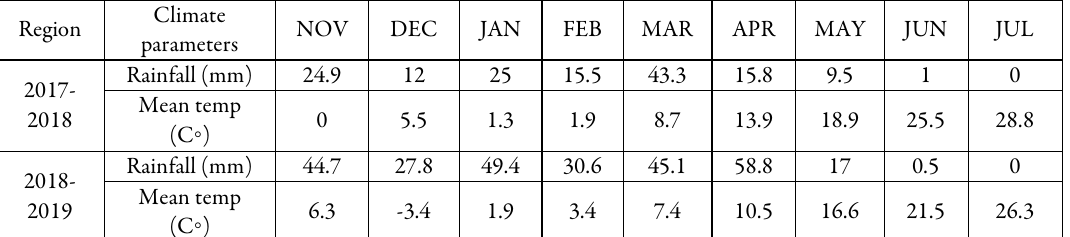
Table 2. Means of monthly rainfall and temperature in 2017-2018 and 2018-2019 at Kurdistan province during the growing seasons Region